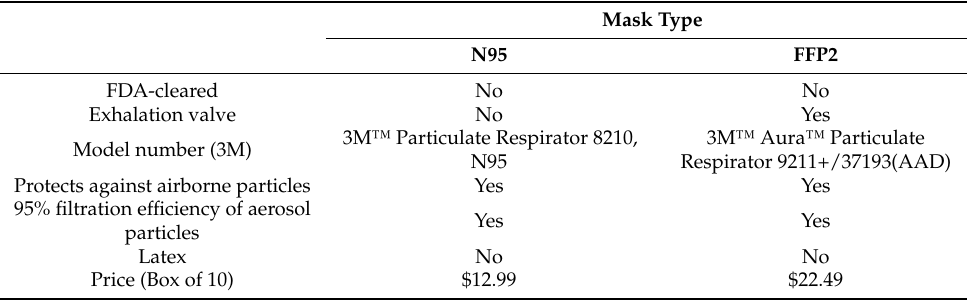
Table 1. Comparison between the two face masks